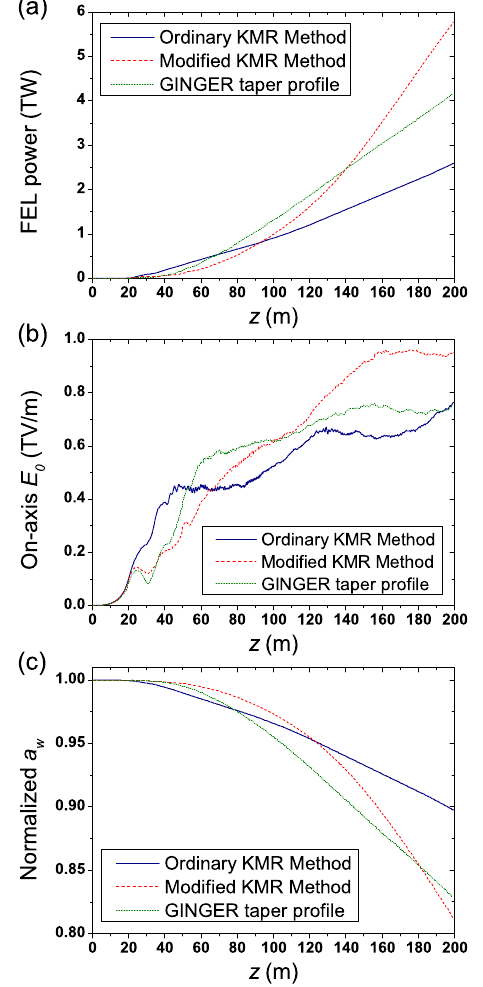
FIG. 6. Evolution of various parameters along the undulator line for the LCLS-II case. The parameters are (a) the FEL power, (b) the on-axis optical field amplitude, and (c) the a ized to its initial value. The three curves shown in each plot are the results of the ordinary KMR method (with ψ modified KMR method (with g ¼ 3 mrad = m), and the GINGER taper profile from Jiao et al.